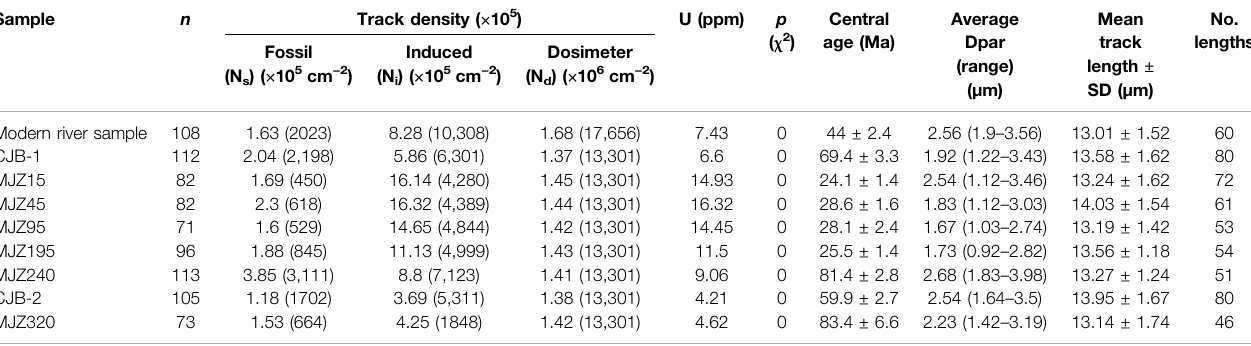
TABLE 1 | Detrital AFT data from sediment samples. Sample